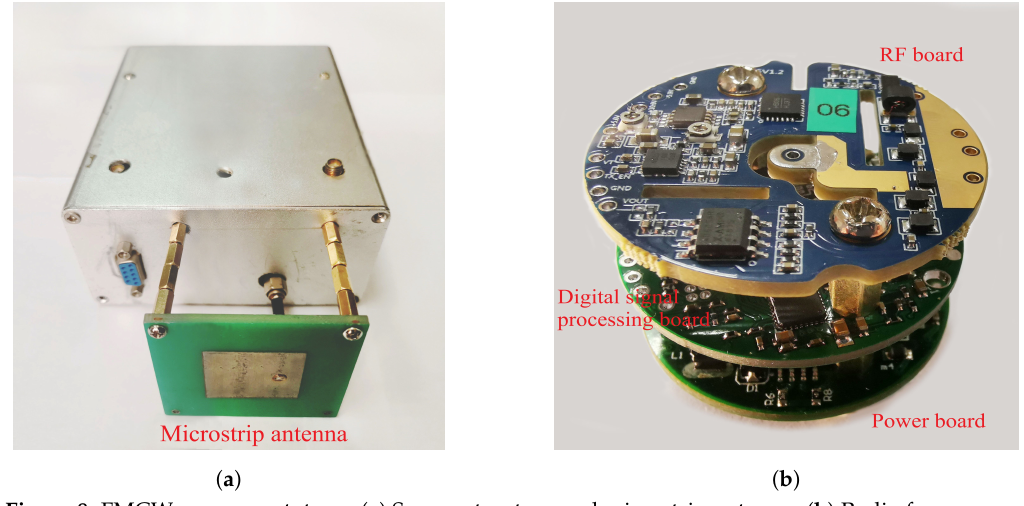
Figure 8. FMCW sensor prototype. ( a ) Sensor structure and microstrip antenna. ( b ) Radio frequency (RF) front-end and signal processing module. Table 2. Specifications of FMCW